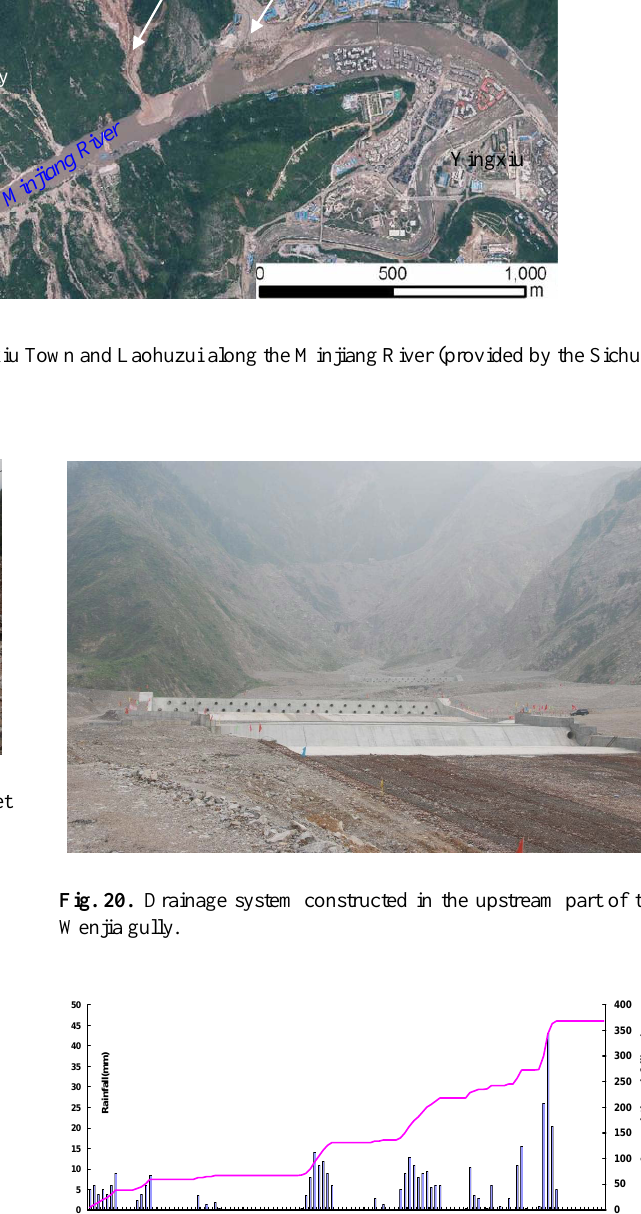
Fig. 20. Drainage system constructed in the upstream part of the Wenjia gully.